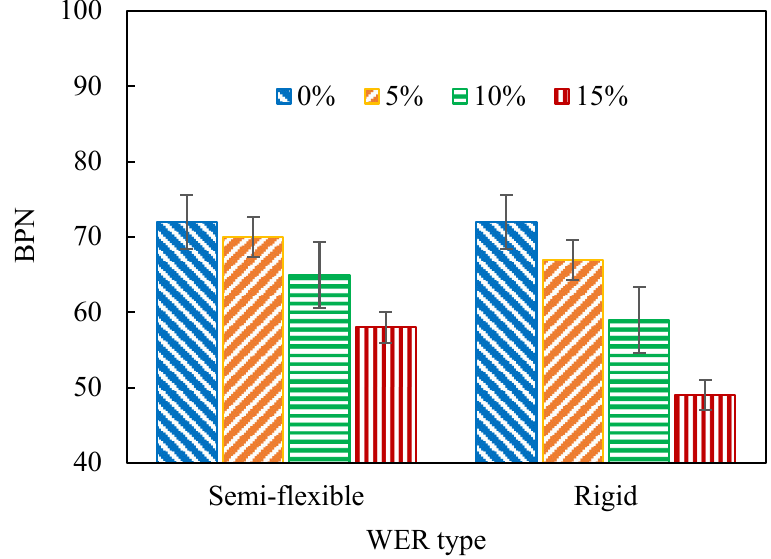
Figure 22. Pendulum friction test result .